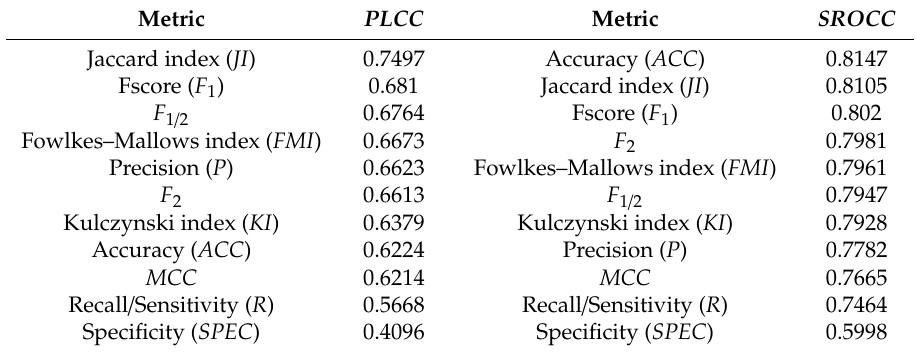
Table 8. The overall correlation between subjective MOS scores and external validation scores.